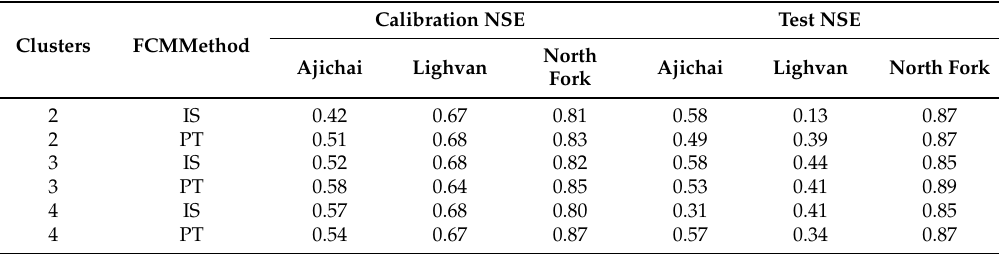
Figure 6. Comparison of clustering validity index by ( a ) Partition Index (SC) and ( b ) Separation Index (S). Table 4. Comparison of Nash-Sutcliffe Efficiency (NSE) indices of HBV model.